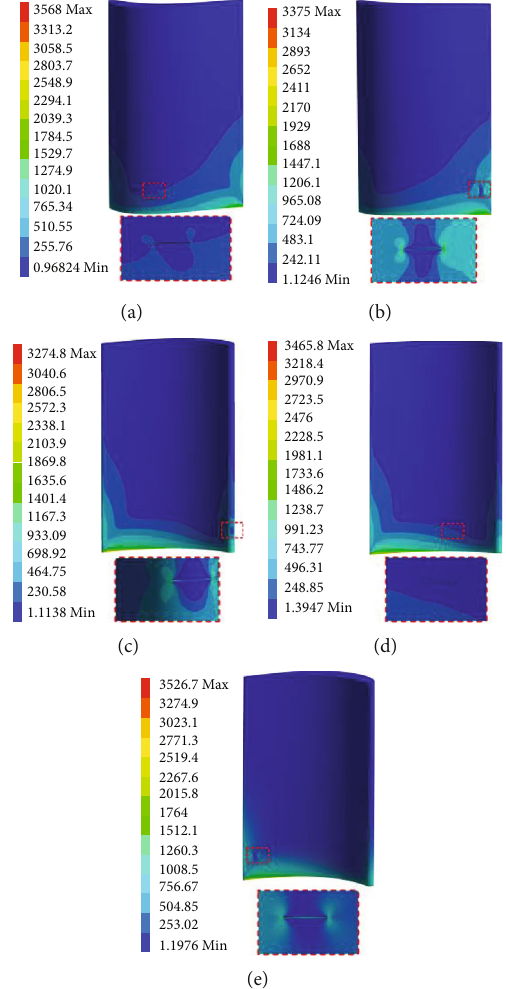
Figure 18: The stress distributions of blades with surface cracks. (a) S . (b) S . (c) P . (d) P . (e) P 20 35 0 20 35